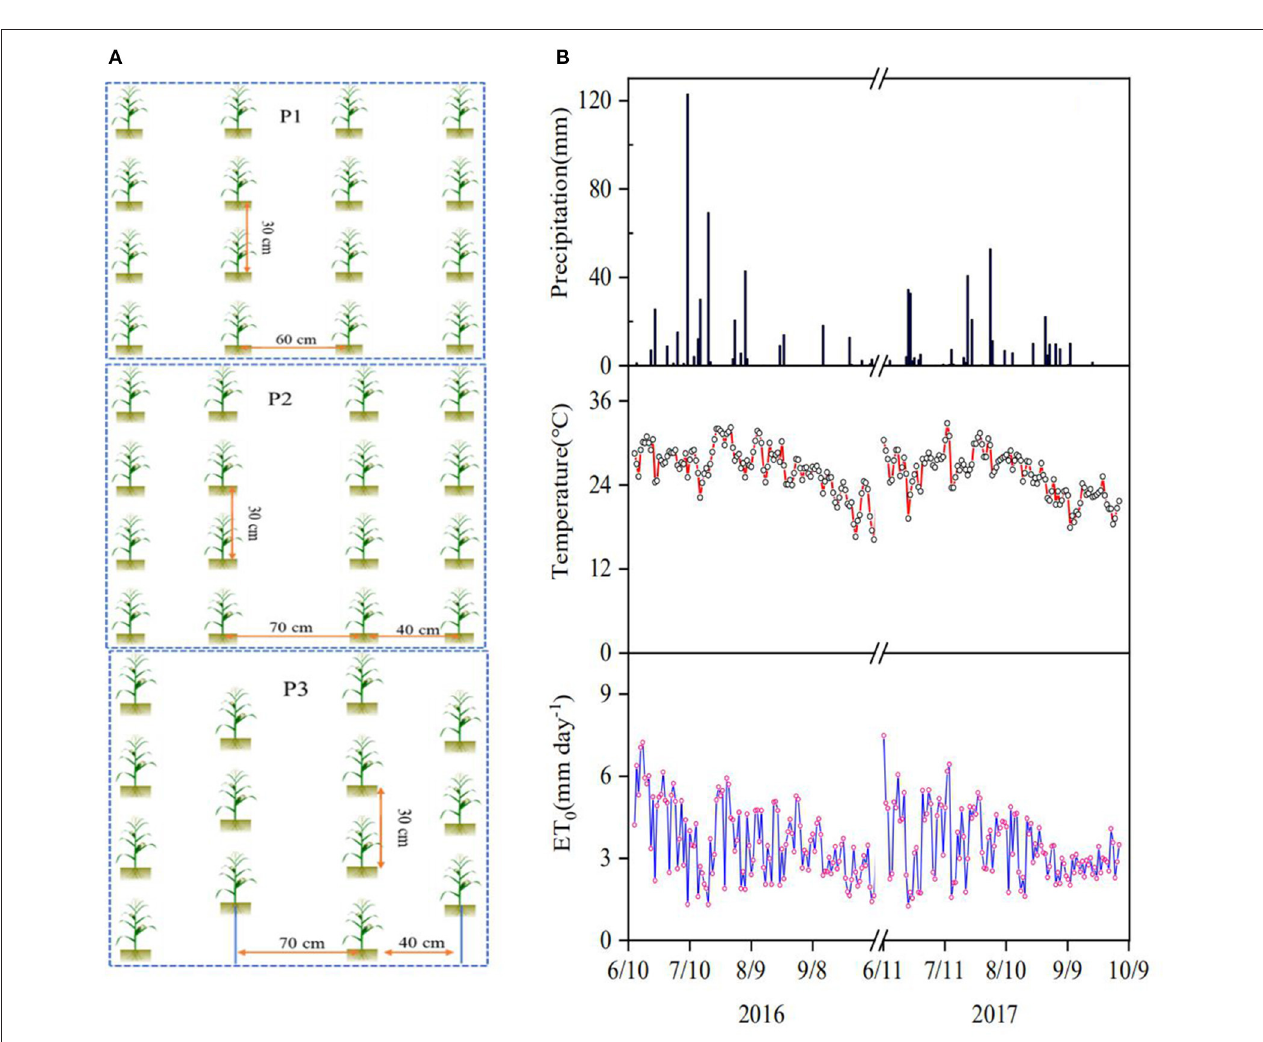
FIGURE 1 | (A) Sketch of the three planting patterns: P1 - Constant 60cm inter-row spacing; P2 – alternate 40cm and 70cm inter-row spacing, and P3 - zig-zag pattern with alternate 40cm and 70cm inter-row spacing; the intra-row spacing is 30cm in all treatments. (B) Changes in air temperature, reference evapotranspiration ( ET 0 ) and precipitation in the 2-year experimental period.